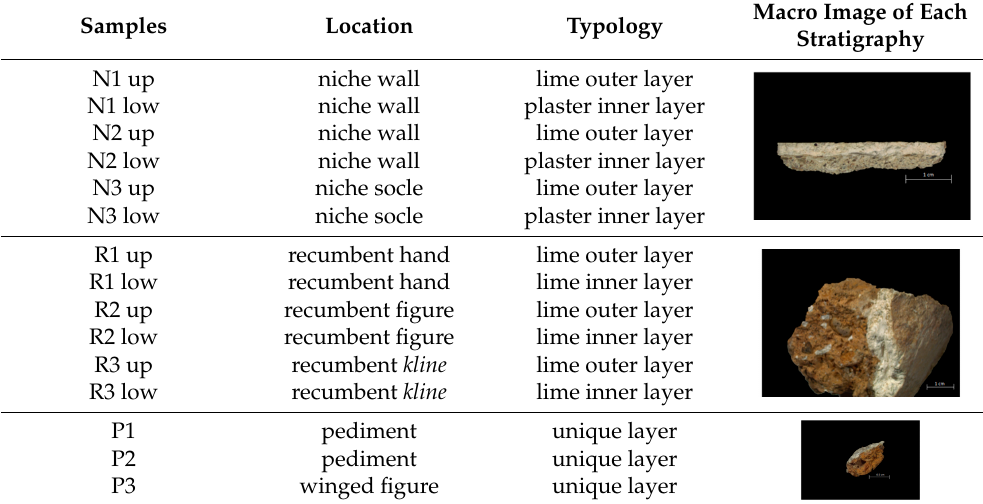
Table 1. Preparatory layers from the niche, recumbent figure, and pediment. Bars of macro images of samples “R” and “N” = 1 cm; bar of samples “P” = 0.5 cm.